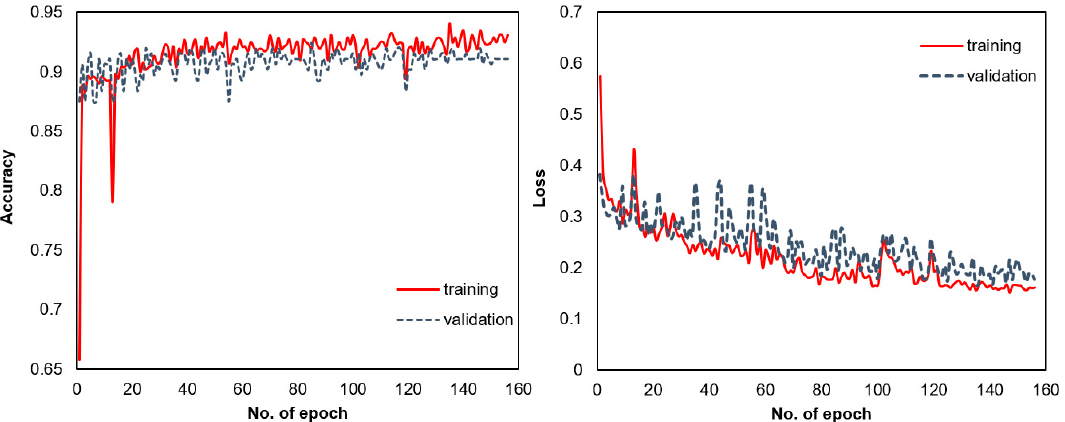
Figure 6. Evolution of the accuracy and loss function during the training and validation of the CNN model as a function of the number of epochs.